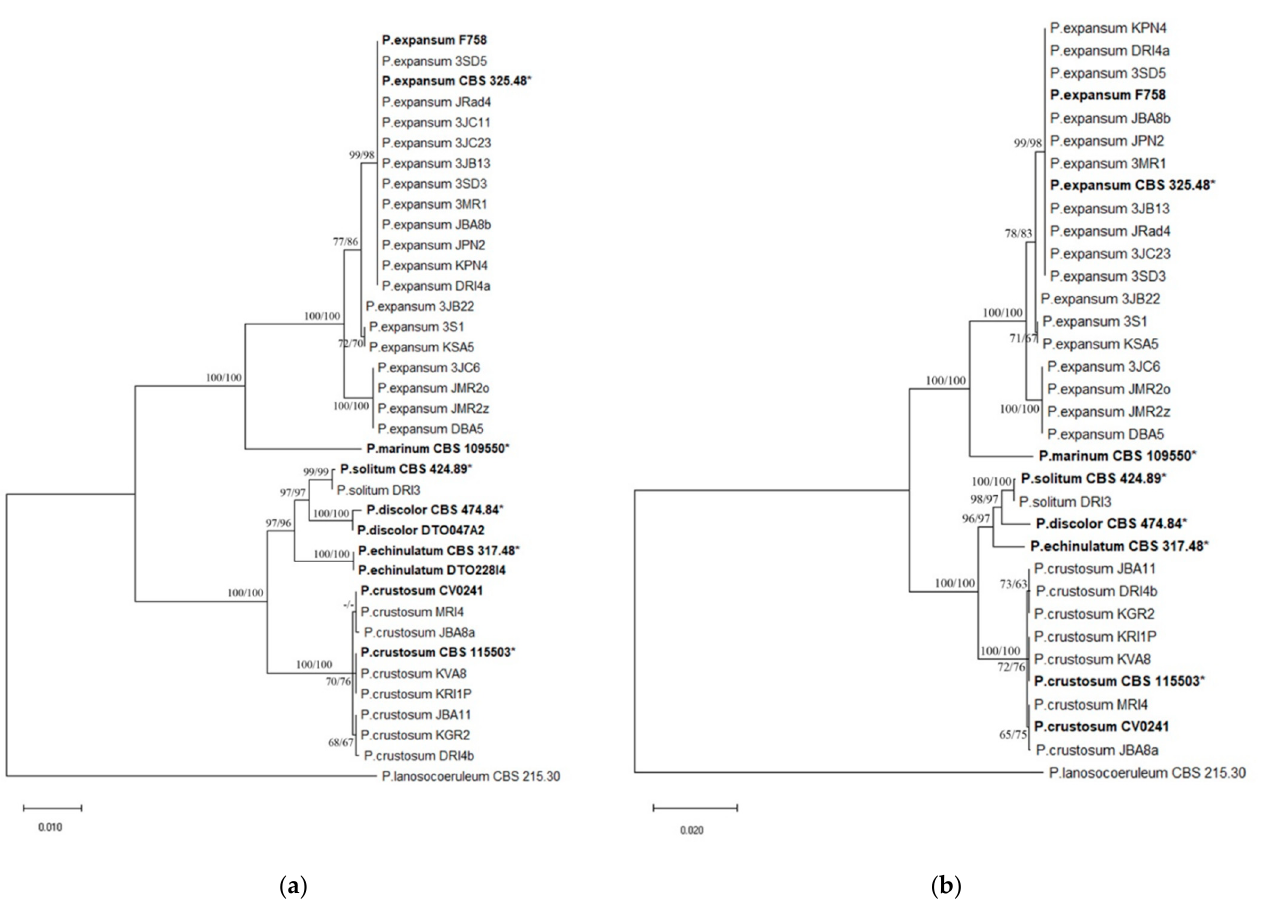
Figure 7. Phylogenetic relationships amongst Penicillium expansum , P. crustosum , and P. solitum based on three ( BenA, CaM , and RPB2 ) ( a ) and four loci (ITS, BenA, CaM , and RPB2 ) ( b ). Bootstrap values larger than 60 of the Maximum Likelihood (ML) and Maximum Parsimony (MP) analysis are shown above or below the branches. The tree is rooted with Penicillium lanosocoeruleum as an outgroup. Numbers on the branches present bootstrap values obtained for 1000 replicates. Bolded isolates are reference isolates, and bolded isolates with * are ex-type isolates.